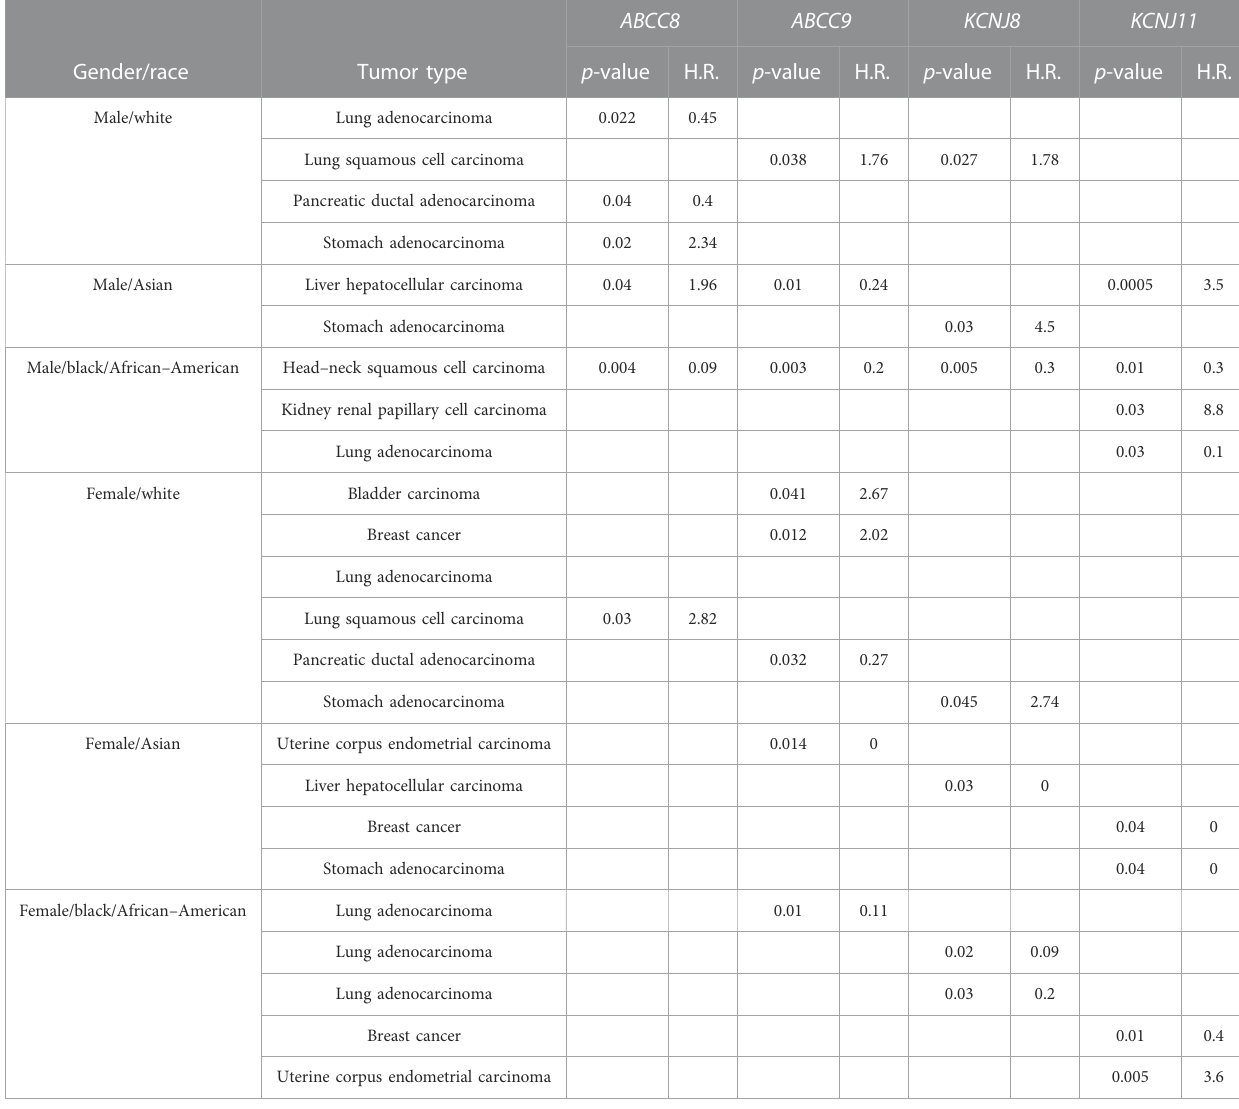
TABLE 6 Hazard ratio (H.R.) of disease progression values for genes and cancer type whose survival KmPlot analyses show signi fi cant results ( p <